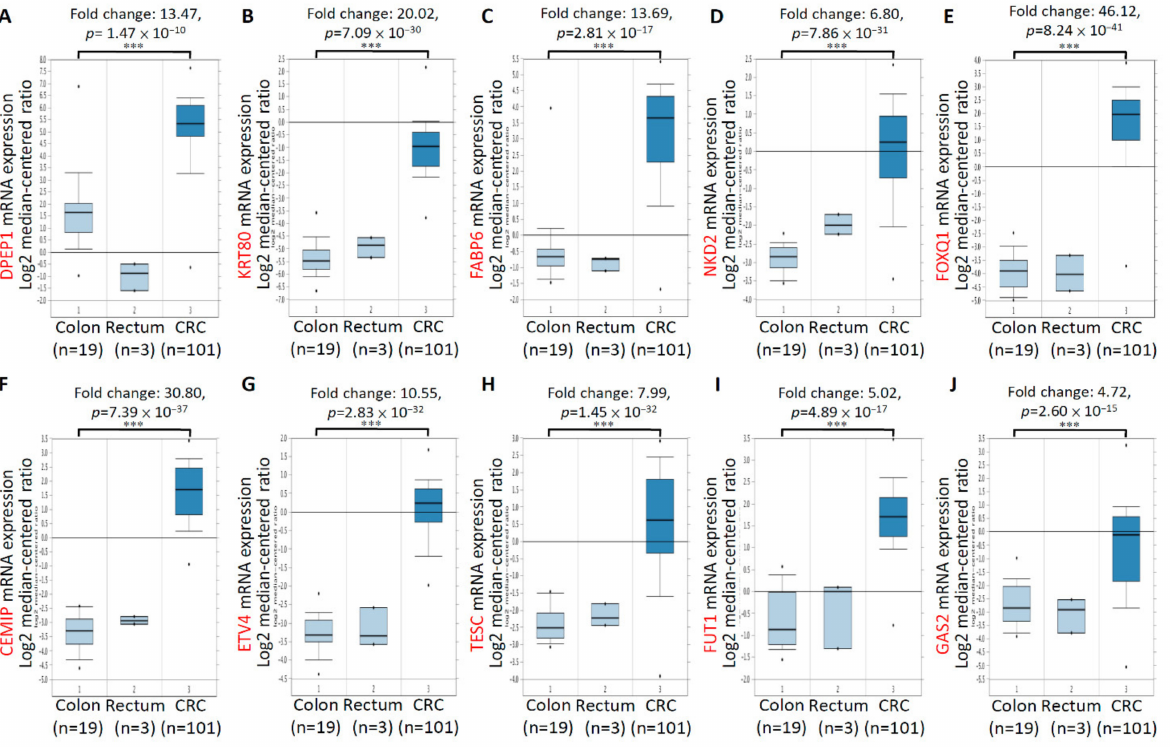
Figure 2. Upregulation of mRNA expression of top 10 upregulated CRC-associated genes using the Oncomine database analysis. The significant increases in the mRNA expression of DPEP1 ( A ), KRT80 ( B ), FABP6 ( C ), NKD2 ( D ), FOXQ1 ( E ), CEMIP ( F ), ETV4 ( G ), TESC ( H ), FUT1 ( I ), and GAS2 ( J ) in CRC tissues ( n = 101) compared to normal colon tissues ( n = 19). *** p <